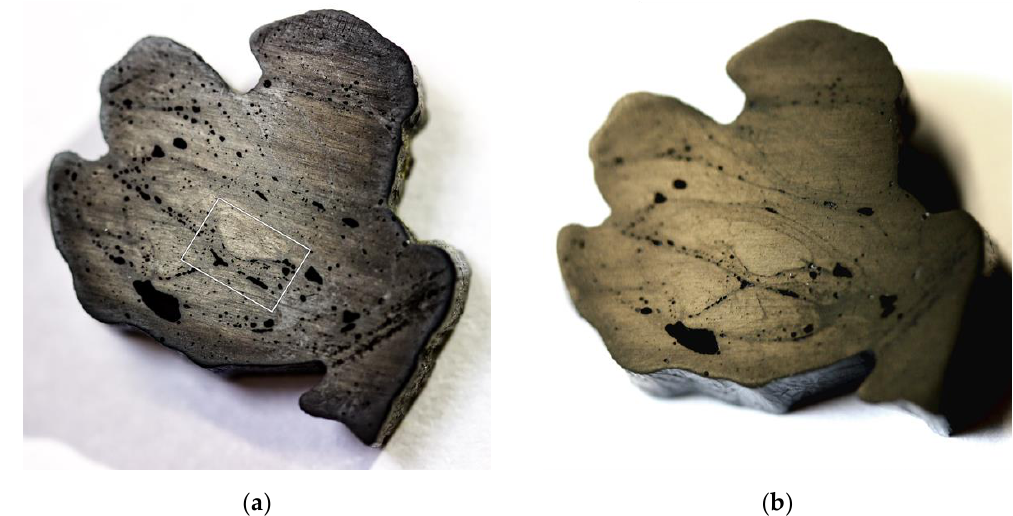
Figure 8. Cross-sectional view of a BUGA carbon-fiber-bundle-retaining sample containing 48×6 48K rovings: ( a ) picture with increased contrast and sharpness to make voids easily visible. Box shows SEM scan area of Figure 9. ( b ) Picture with oblique yellow lighting revealing resin bridges (matte) and rovings (shiny).